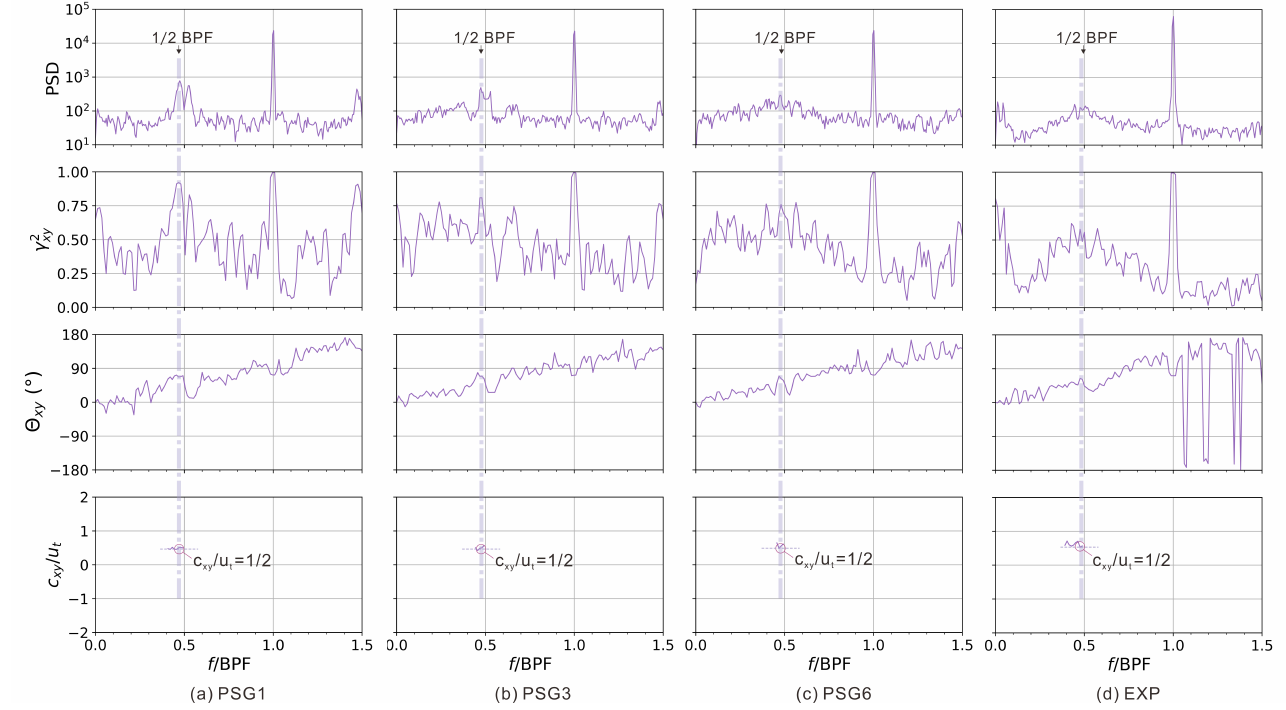
Figure 6. Spectral analysis of the wall pressure in the stationary reference frame for s / C = 2.6% at Φ =